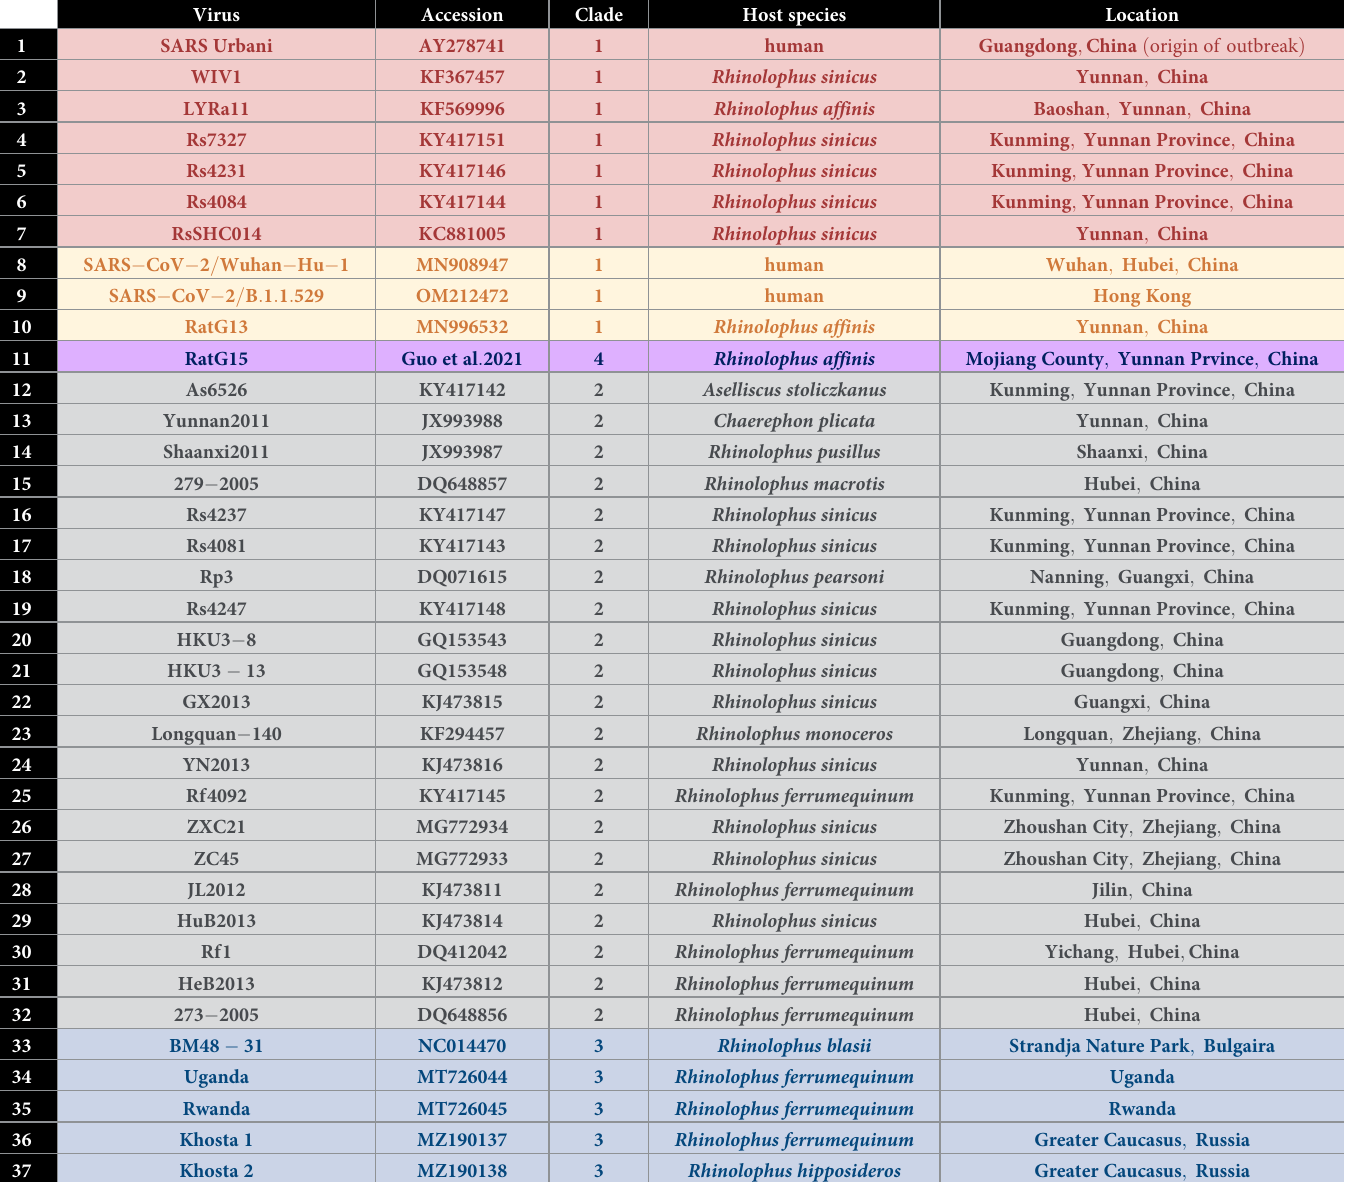
Table 1. Sarbecovirus sequences used in this